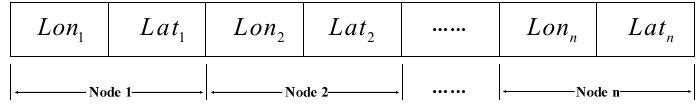
Figure 3. Schematic diagram of real-number chromosome encoding in WSN deployment. Note: Lon i and Lat i represent the longitude and latitude of node i , respectively.